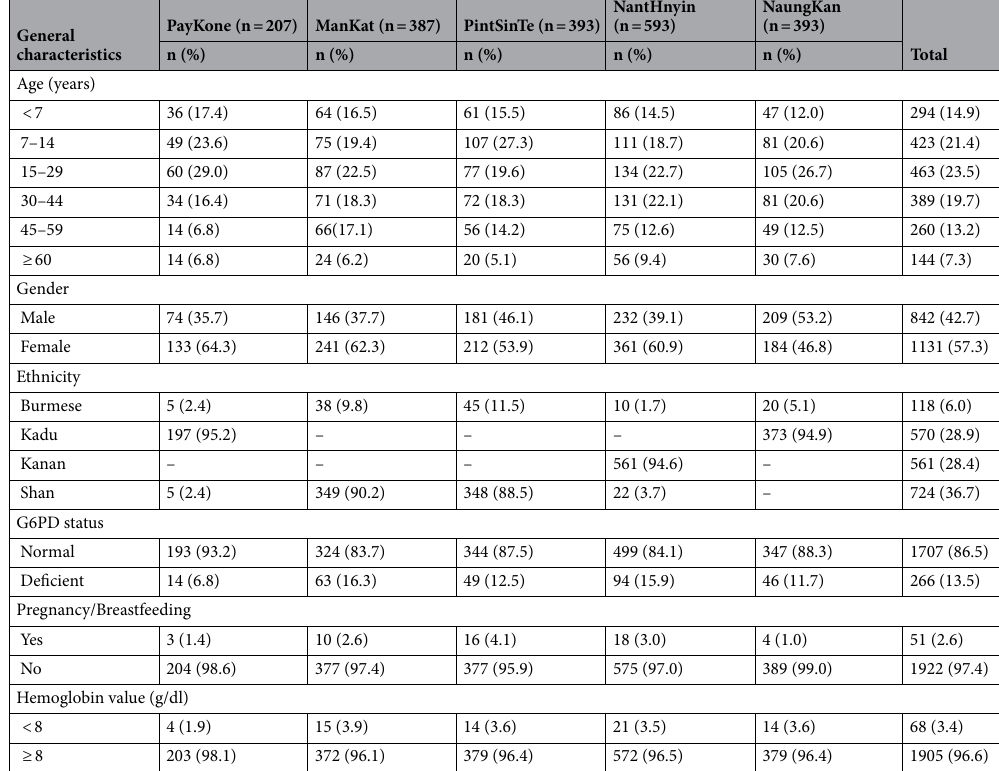
Table 1. General characteristics of targeted study population residing in each study village (n = 1973).